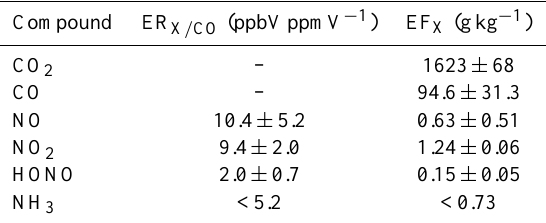
Table 2. Molar emission ratios (ERs) relative to CO and emission factors (EFs) of the major inorganic gases as obtained from four fire